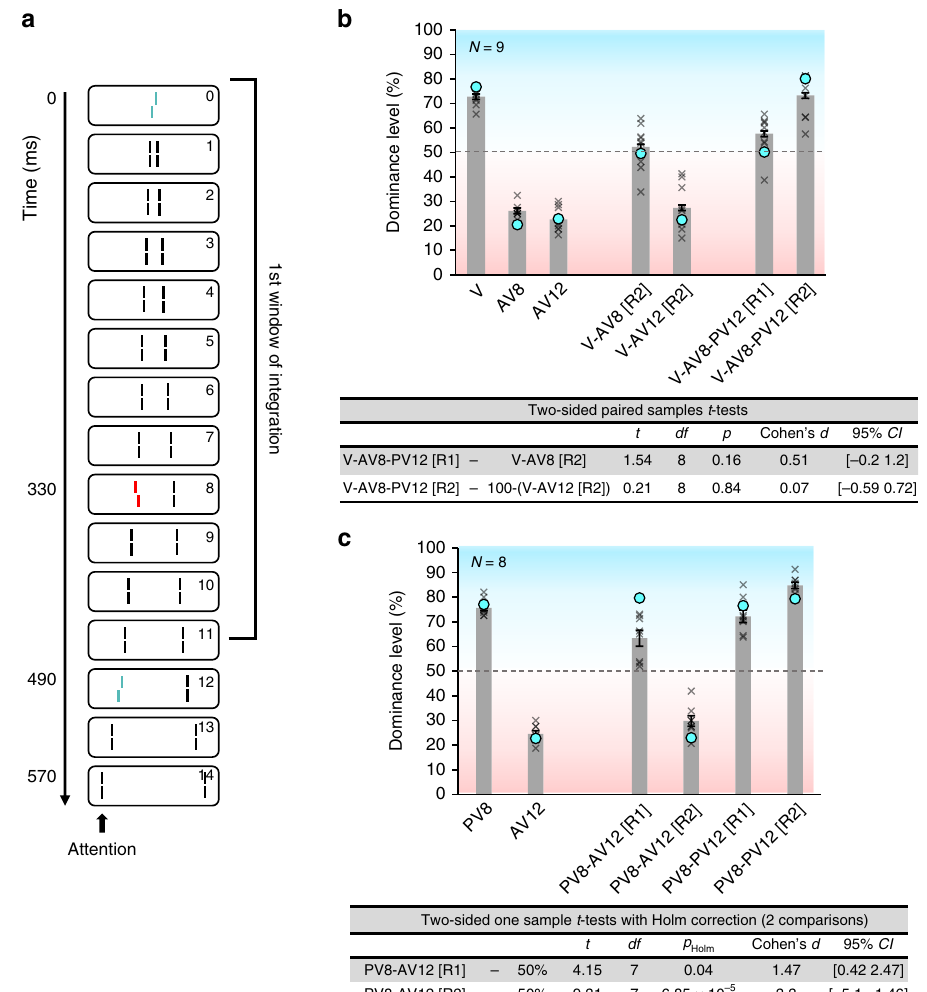
Fig. 3 Experiments 2 and 3. a Experiment 2. A central vernier and an anti-vernier in frame 8 (330 ms) were presented before 450 ms. A pro-vernier was presented in frame 12 (490 ms), after 450 ms. b Results of experiment 2. In condition V-AV8 [R2], observers were not able to report the direction of the fl ank offset, suggesting mandatory integration. In condition V-AV12 [R2], observers were able to report the direction of the fl ank offset, suggesting that the fl ank offset did not integrate with the central vernier offset. We compare dominances in conditions V-AV8-PV12 [R1] and V-AV8-PV12 [R2] to V-AV8 [R2] and 100 − (V-AV12 [R2]), respectively, to test whether the addition of the third offset changed the integration. Observers were not able to report the direction of the central vernier in condition V-AV8-PV12 [R1], whereas they could report the direction of the pro-vernier in frame 12 (V-AV8-PV12 [R2]). We suggest that integration only occurs within discrete windows of integration. Even offsets that are in close spatio-temporal proximity do not integrate if they are in different windows. These results were well replicated by the model (see Fig. 5). Crosses indicate individual data. c Results of experiment 3. The fl ank verniers were in the same frames as in experiment 2, but there was no central vernier. When the fl ank verniers in frame 8 and 12 were in opposite directions, observers were able to report the individual offsets (PV8-AV12 [R1] and PV8-AV12 [R2]). Thus, the fi rst window of integration seems to start with stimulus onset. These results are well replicated by the model (blue circles). Error bars represent s.e.m. Source data are provided as a Source Data fi